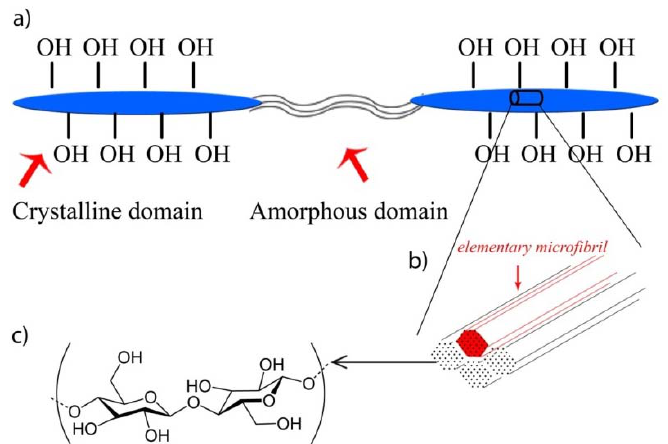
Figure 1. ( a ) Crystalline domain and amorphous domain of cellulose macroscopic fibers; ( b ) elementary microfibrils of cellulose; ( c ) cellulose chain, redrawn based on Peng et al . [14] and Himmel et al .